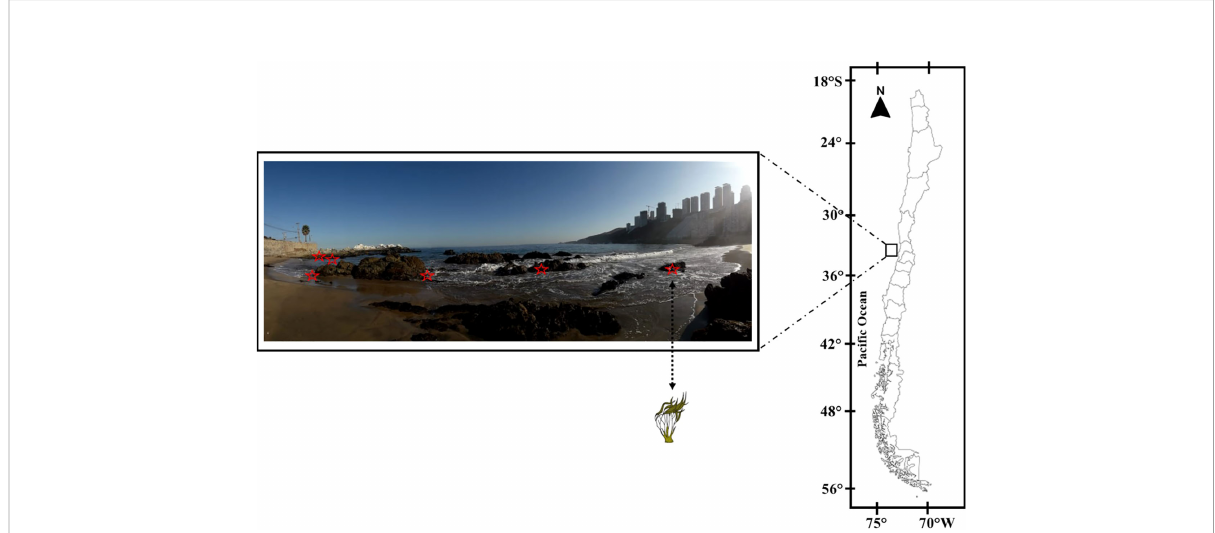
FIGURE 1 Sampling area at Cochoa Beach in Valpara ı ́ so Bay (32°57 ′ 19"S; 71°32 ′ 52"W) during daily cycle experiments throughout the seasons between 2019 and 2020 with Lessonia spicata